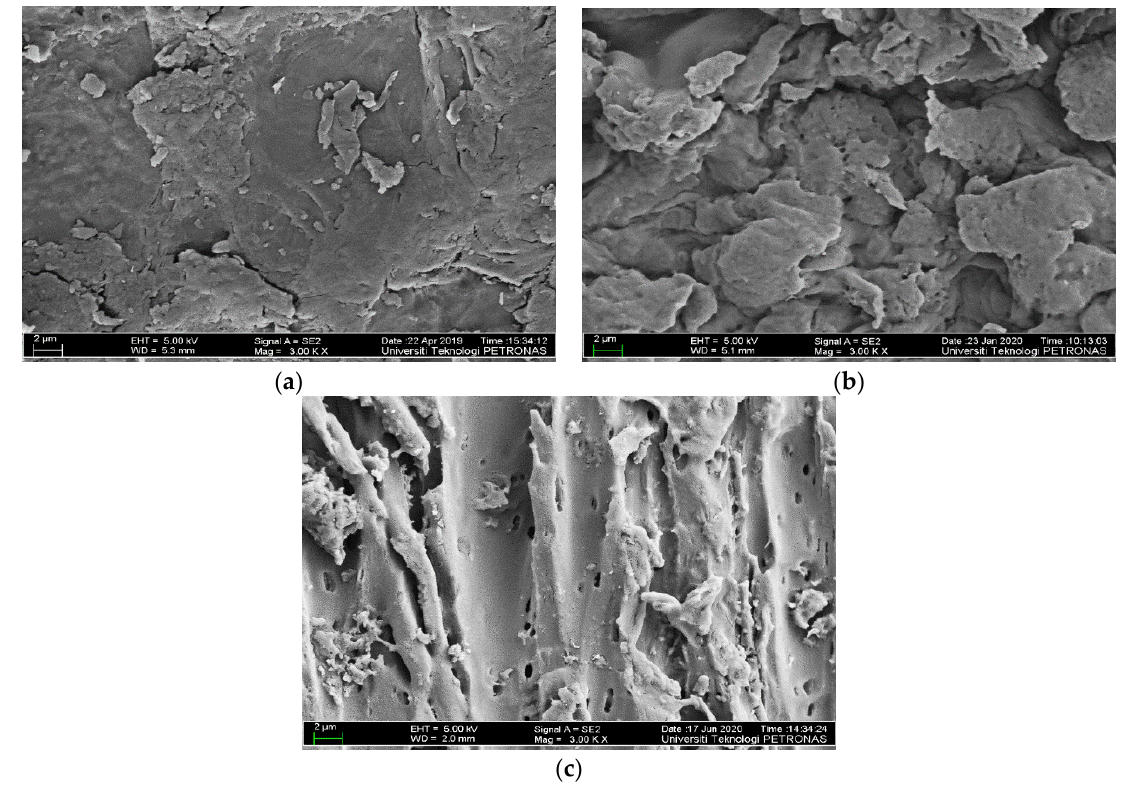
Figure 6. FESEM images at magnification of 3000×: ( a ) raw RSS, ( b ) RSS-IL 500, and ( c ) RSS-IL 800.